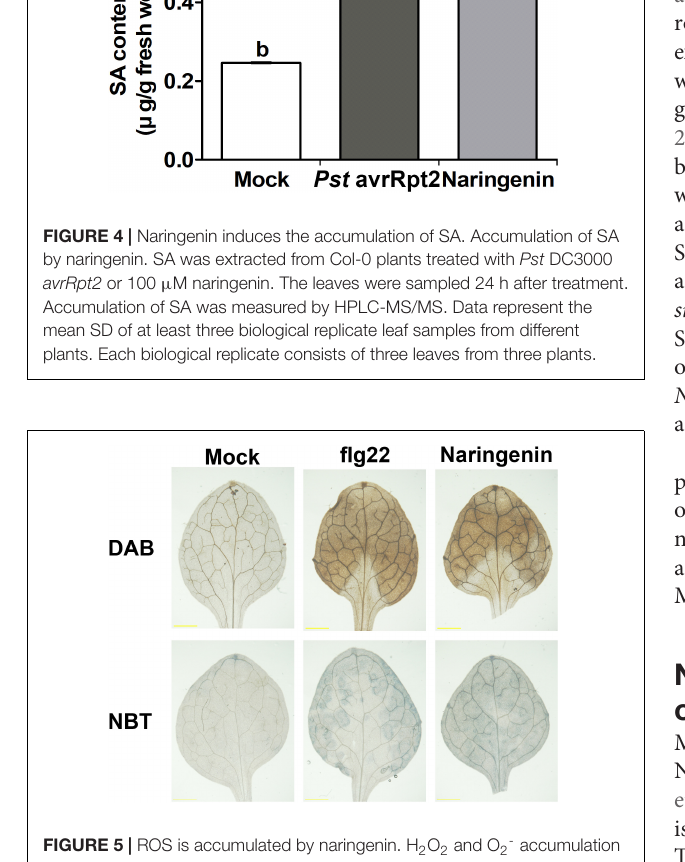
FIGURE 5 | ROS is accumulated by naringenin. H 2 O 2 and O 2 - accumulation was visualized in Col-0 leaves after 0.5 µ M flg22 or 100 µ M naringenin treatment. The leaves were sampled at 24h after treatments and stained with DAB and NBT. Scale bar represents 1 mm. The experiment was repeated three times with similar